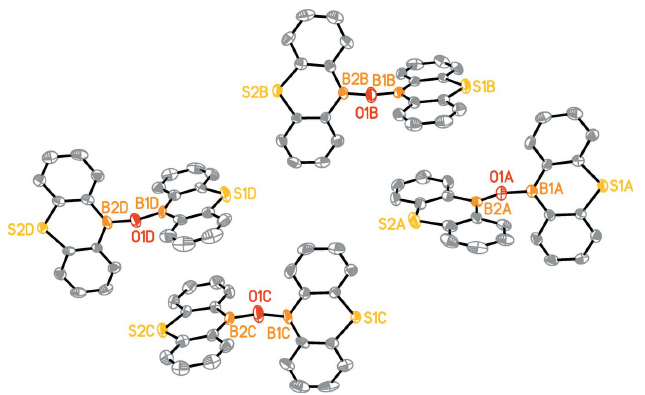
Figure 4 A perspective view of both molecules in the asymmetric unit of (II). H atoms are omitted for clarity. Only B, O and S atoms are